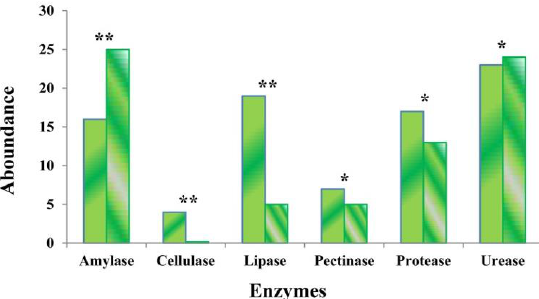
Fig. 5. Enzyme production frequency among bacteria (left columns) and archaea (right columns) obtained from Tis solar saltern:*= not significance (p>0.05), **= significance (p<0.05).